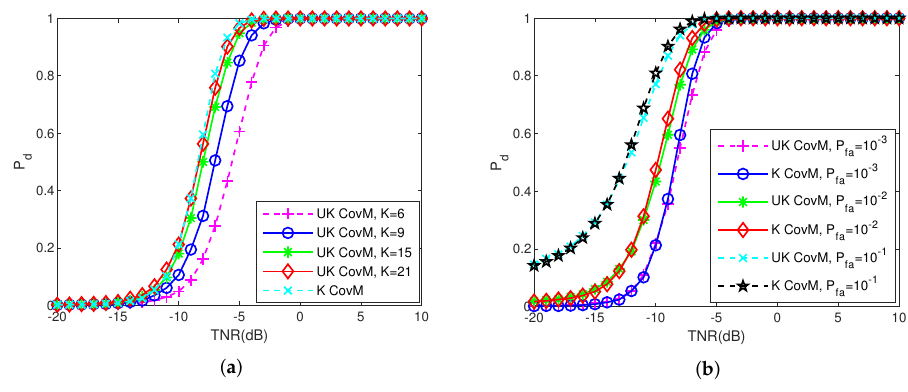
Figure 4. The variation of P d with TNR. ( a ) DNR = − 30 dB, P fa = 10 − 3 . ( b ) DNR = − 30 dB, K = 18.